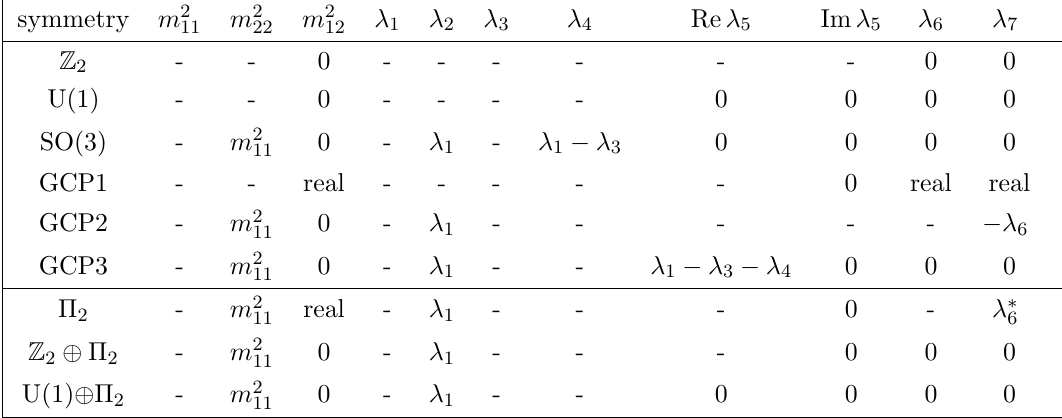
Table 2 . Impact of the symmetries de(cid:12)ned in table 1 on the coe(cid:14)cients of the 2HDM scalar potential [cf. eq. (2.1)] in a basis where the symmetry is manifest. A short dash indicates the absence of a constraint. A scalar potential that is simultaneously invariant under Z 2 and (cid:5) 2 is also invariant under GCP2 in another scalar (cid:12)eld basis [20, 56]. Likewise, a scalar potential that is simultaneously invariant under U(1) and (cid:5) 2 is also invariant under GCP3 in another scalar (cid:12)eld basis [56]. The symbol is being used above to indicate that two symmetries are enforced (cid:8) simultaneously within the same scalar (cid:12)eld